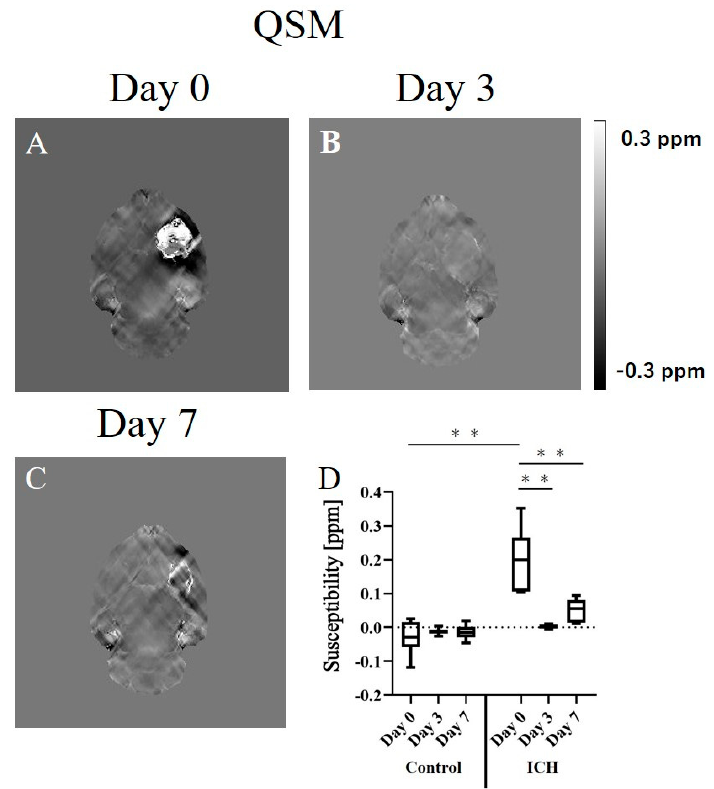
Figure 2. Representative quantitative susceptibility mapping (QSM) images of the intracranial hemorrhage (ICH) rat model on postoperative days 0 ( A ), 3 ( B ), and 7 ( C ). ( D ) The graph depicts the longitudinal changes in the susceptibility of the hemorrhage and normal area. ** p < 0.01.